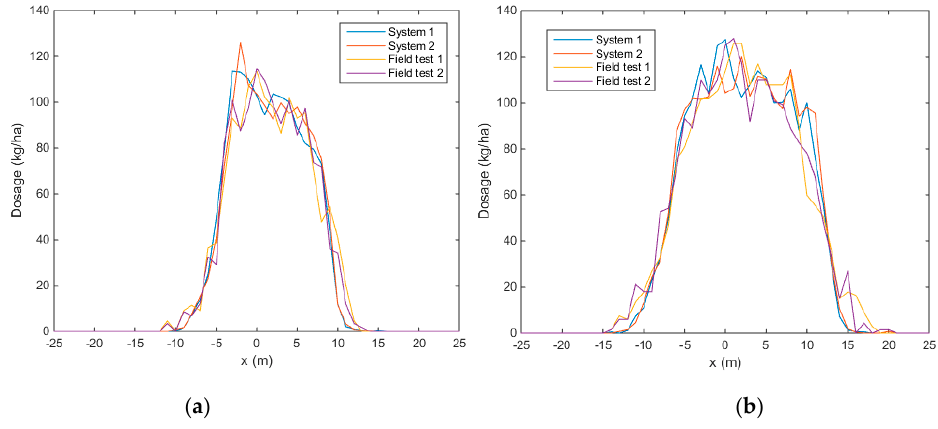
Table 8. Correlation coefficients between transverse spread patterns for configuration A and B measured with the camera system and with collection trays on the field. A grid resolution of 1 m × 1 m was used (51 cells).